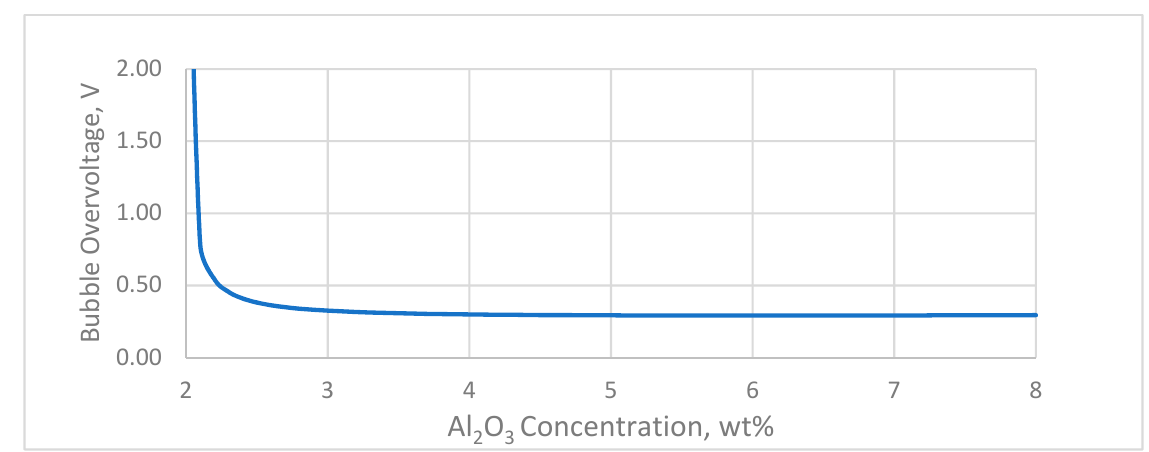
Figure 7. Bubble overvoltage in relation to the alumina concentration. As can be seen in Figure 7, the bubble voltage drop goes towards infinity when the alumina concentration gets close to the critical concentration where the anode effect occurs. At about 3% alumina concentration, it reaches a minimum that mainly depends on the magnitude of the anodic current density.